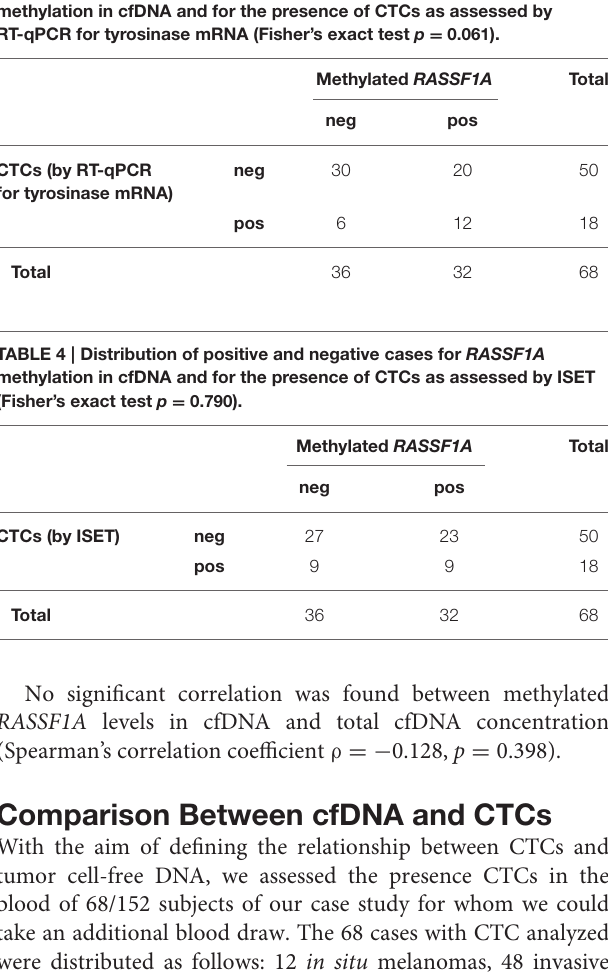
TABLE 3 | Distribution of positive and negative cases for RASSF1A methylation in cfDNA and for the presence of CTCs as assessed by